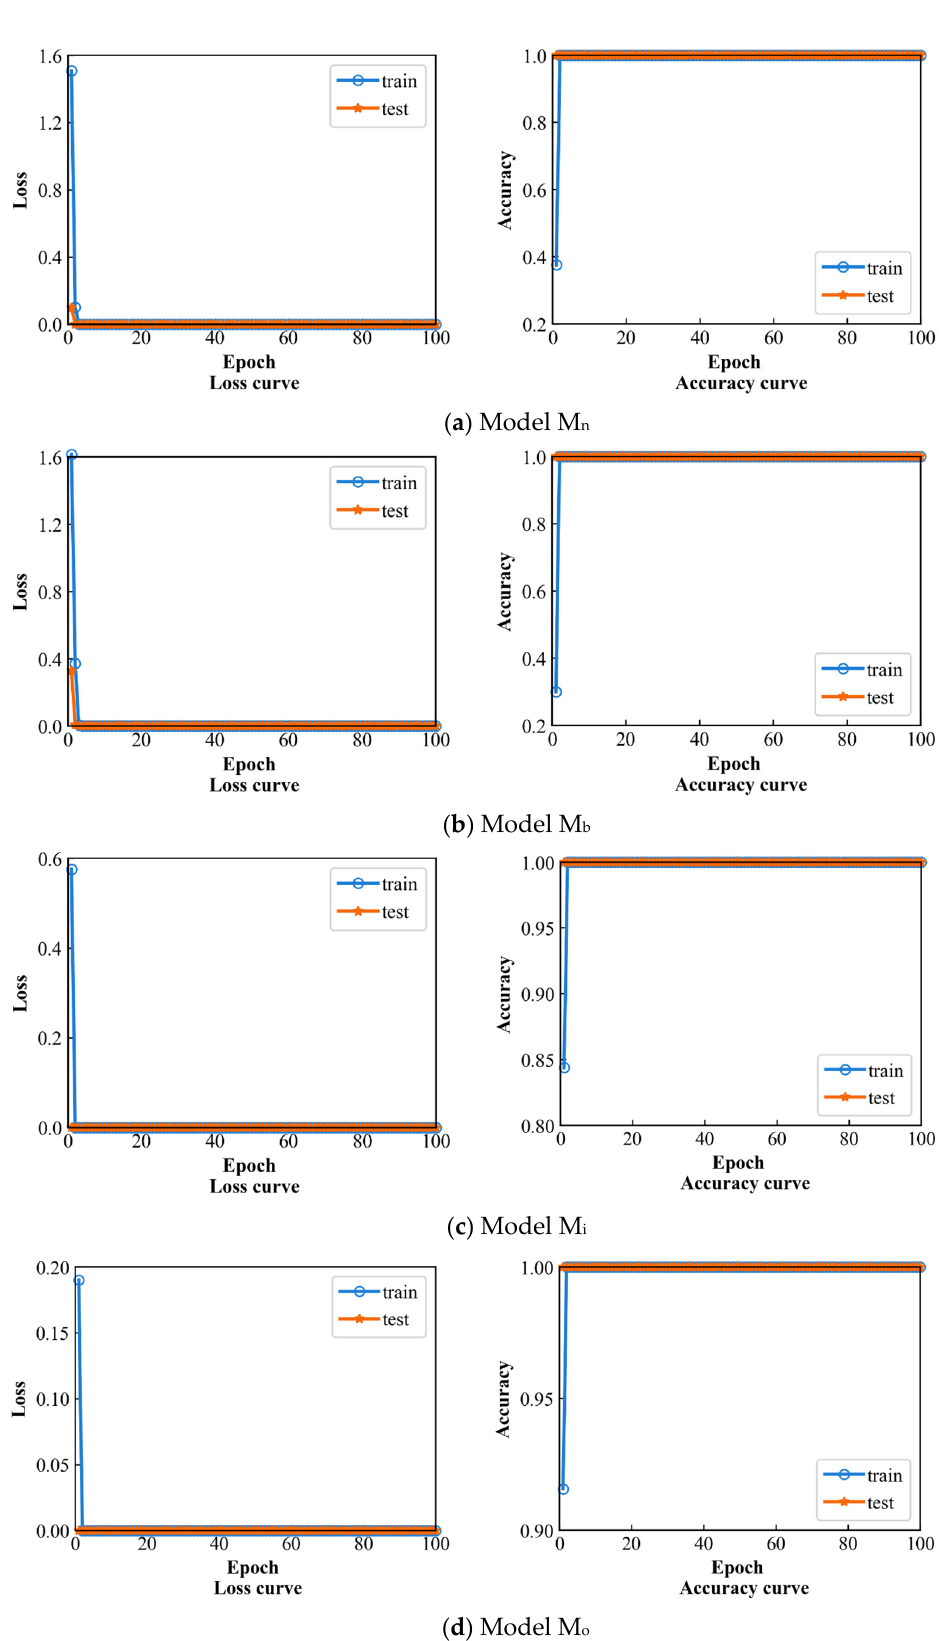
Figure 7. Loss and accuracy curve of local fault diagnosis model.